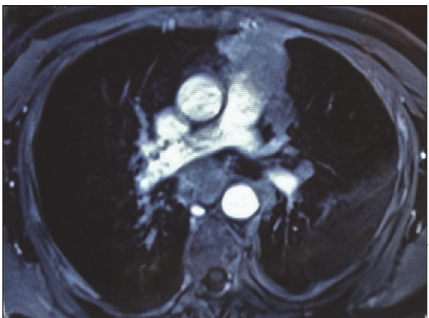
Figure 3: MRI chest revealing an anterior mediastinal mass which is infiltrating the surrounding lung